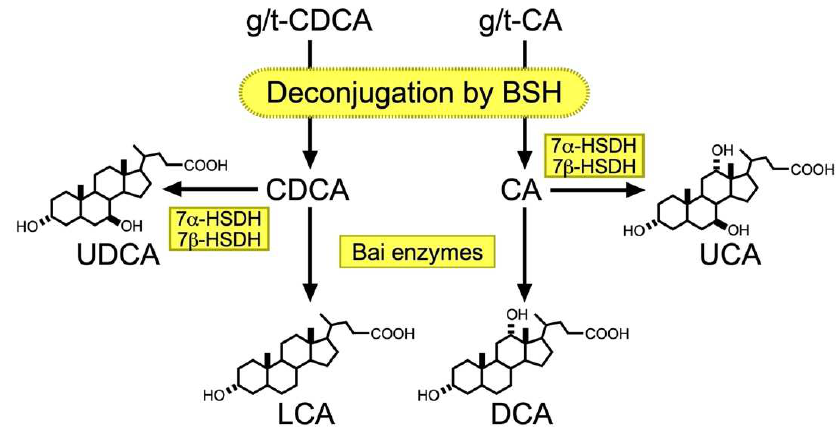
Figure 2. Secondary BA biosynthesis. Primary BAs are initially deconjugated by BSH, which is encoded by most gut microbiota. Deconjugated CDCA is then converted to UDCA and by 7α- and 7β-HSDH expressed in different bacteria or LCA by multiple steps of catalytic reactions by Bai enzymes in Clostridium spp. Deconjugated CA is also converted to UCA by 7α- and 7β-HSDH or DCA by Bai enzymes.